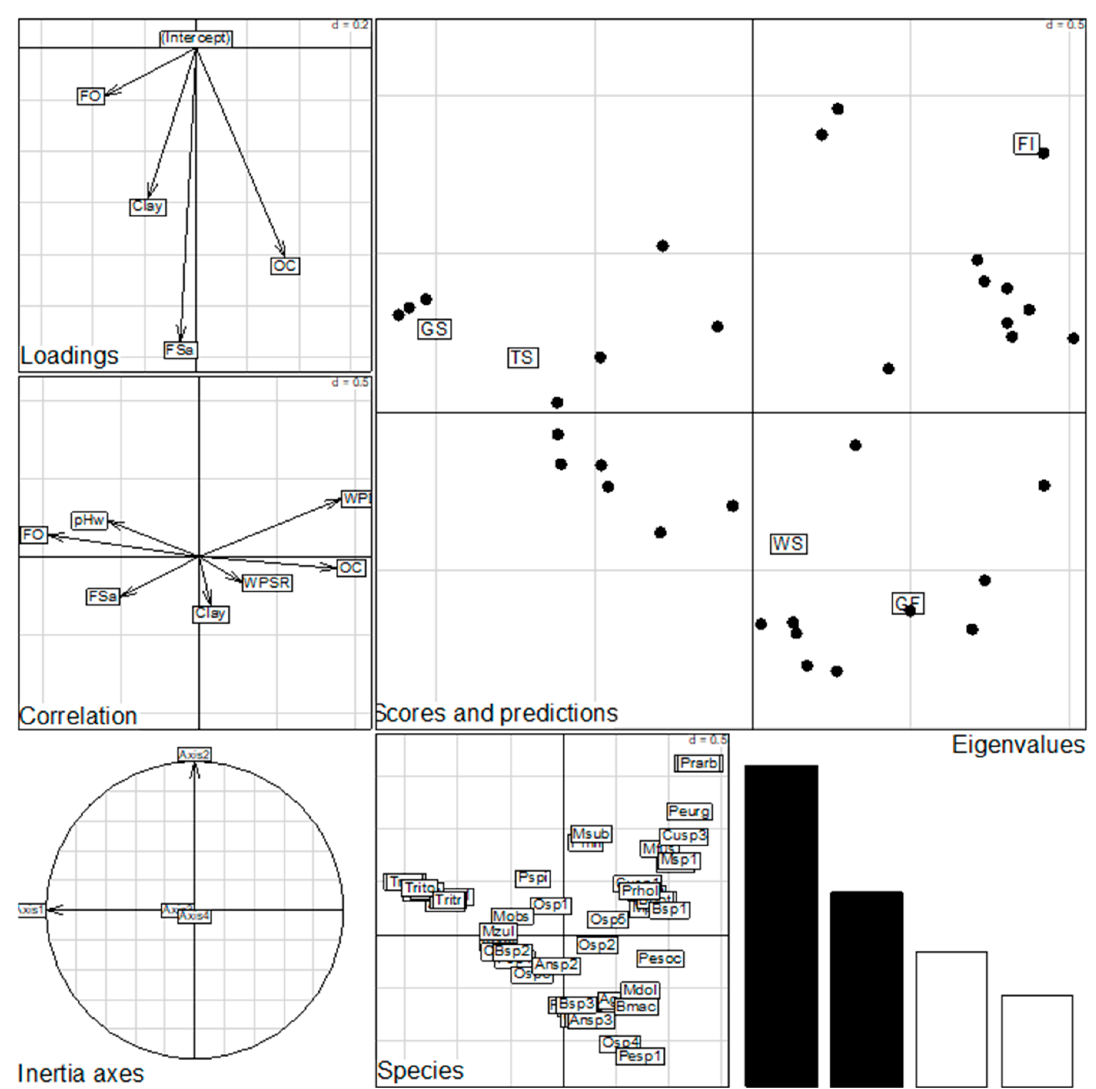
Figure 3. Diagram of CCA ordination of habitat-specific diversity and abundance of collected termites in dependence of environmental variables.